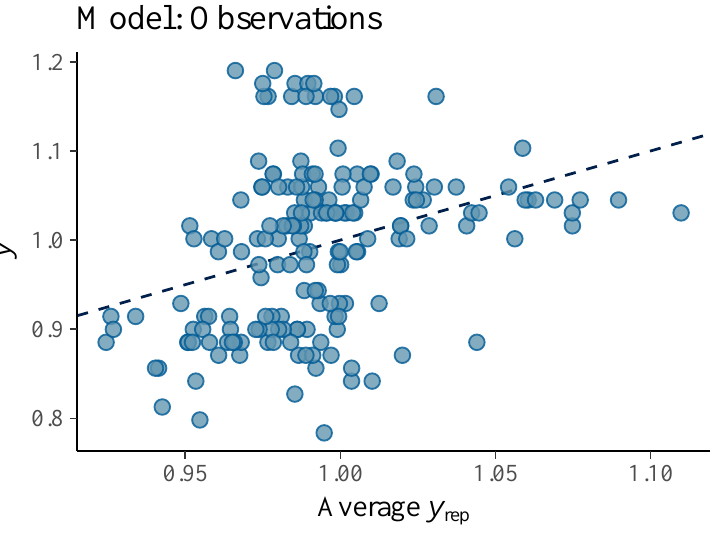
Figure 4. Ball velocity observations (dots) vs. average simulated value of the ball speed (line) from the posterior predictive distribution of the Observations model. This graphical representation suggests that Observations model leaves a large amount of variation in the data unexplained.